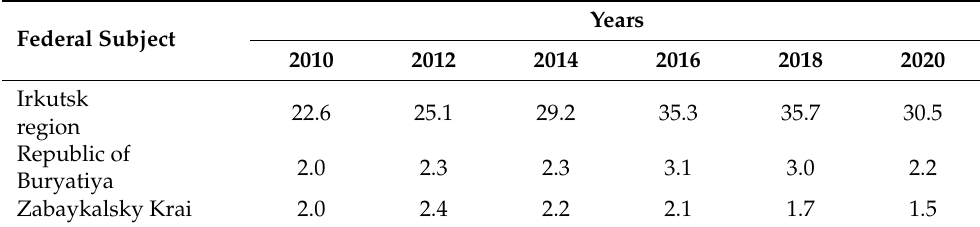
Table 2. Logging volumes in the Baikal region (2010–2020), million m 3 /year.